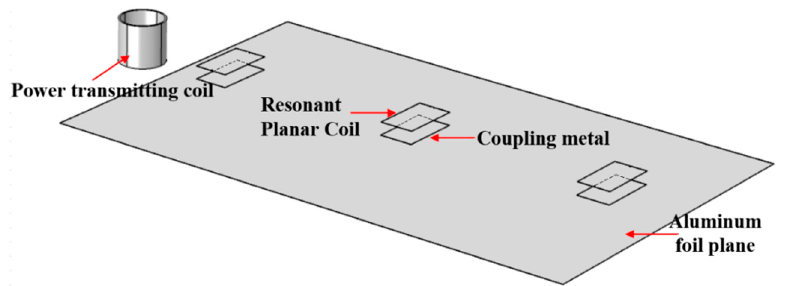
Figure 8. DWPT system simulation model.